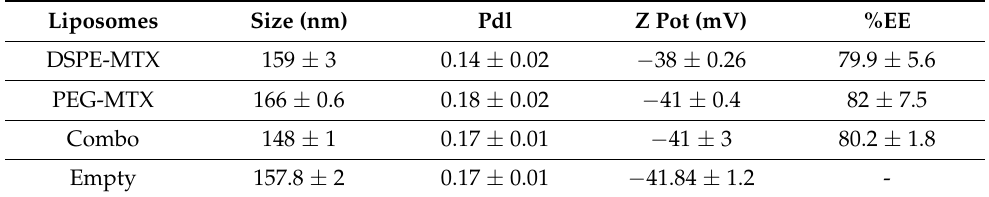
Table 2. Sizes, PdI, ζ -Potential and encapsulation efficiency (%EE) of the formulation used.